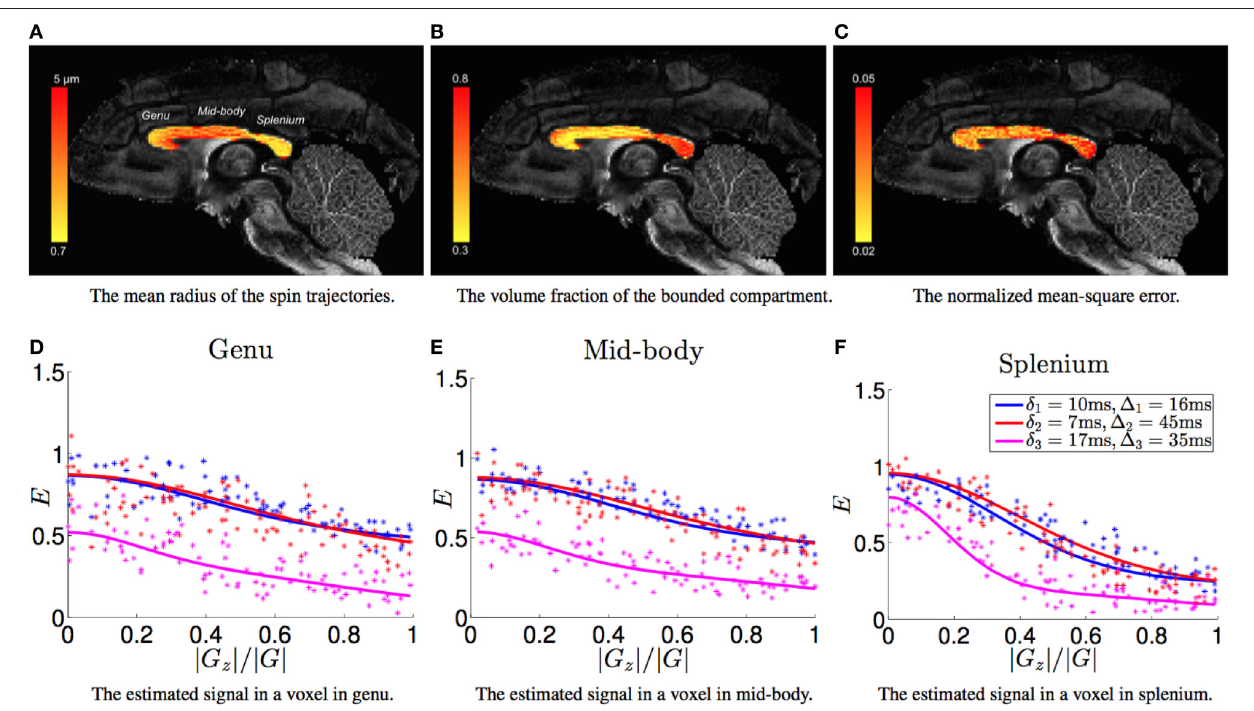
FIGURE 2 | (A–C) shows the estimated radius of bounded trajectories, the fraction of the bounded compartment in the dMRI signal and the normalized mean-square error between the estimated signal and the measurements, respectively. (D–F) shows the measured (dot points) signal and the estimated signal (solid lines) in three representative voxels from the genu, mid-body and splenium areas, respectively, with the horizontal axis being absolute value of the inner product between the gradient direction and the axon orientation.